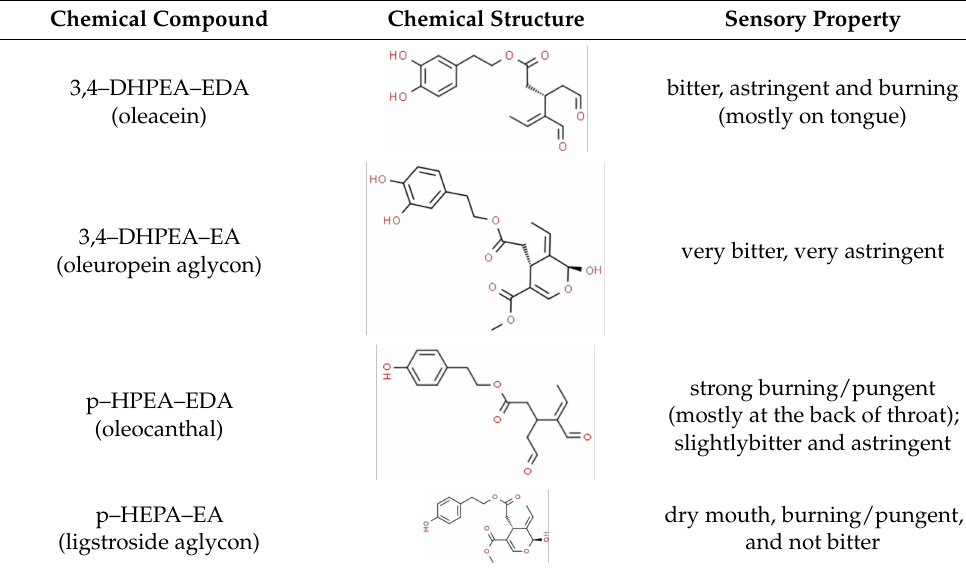
Table 1. Some of the main phenolic compounds responsible for the bitterness, astringent, and pungent sensation of